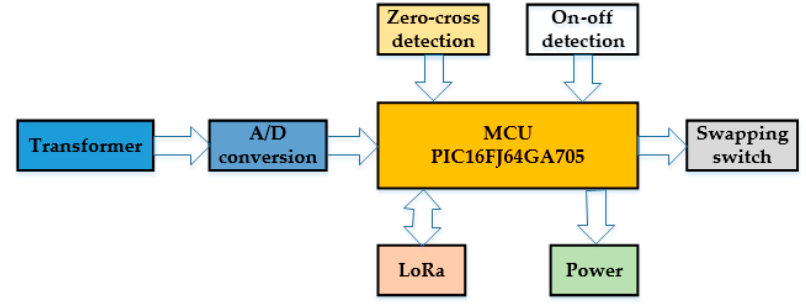
Figure 4. Structure of the user controller.